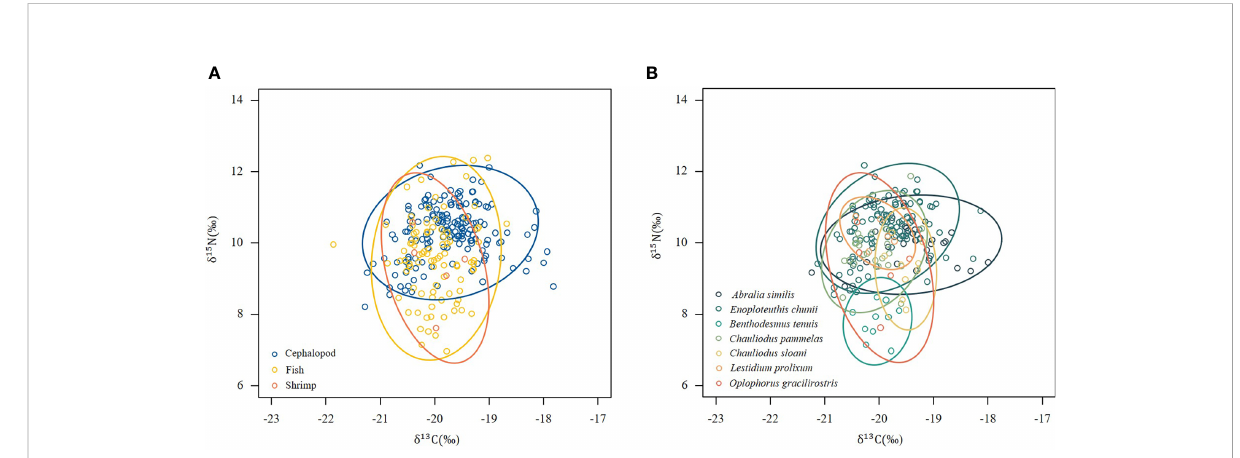
FIGURE 3 Isotopic niche of different groups and different species of micronekton. (A) Different groups of micronekton, (B) Different species of micronekton.